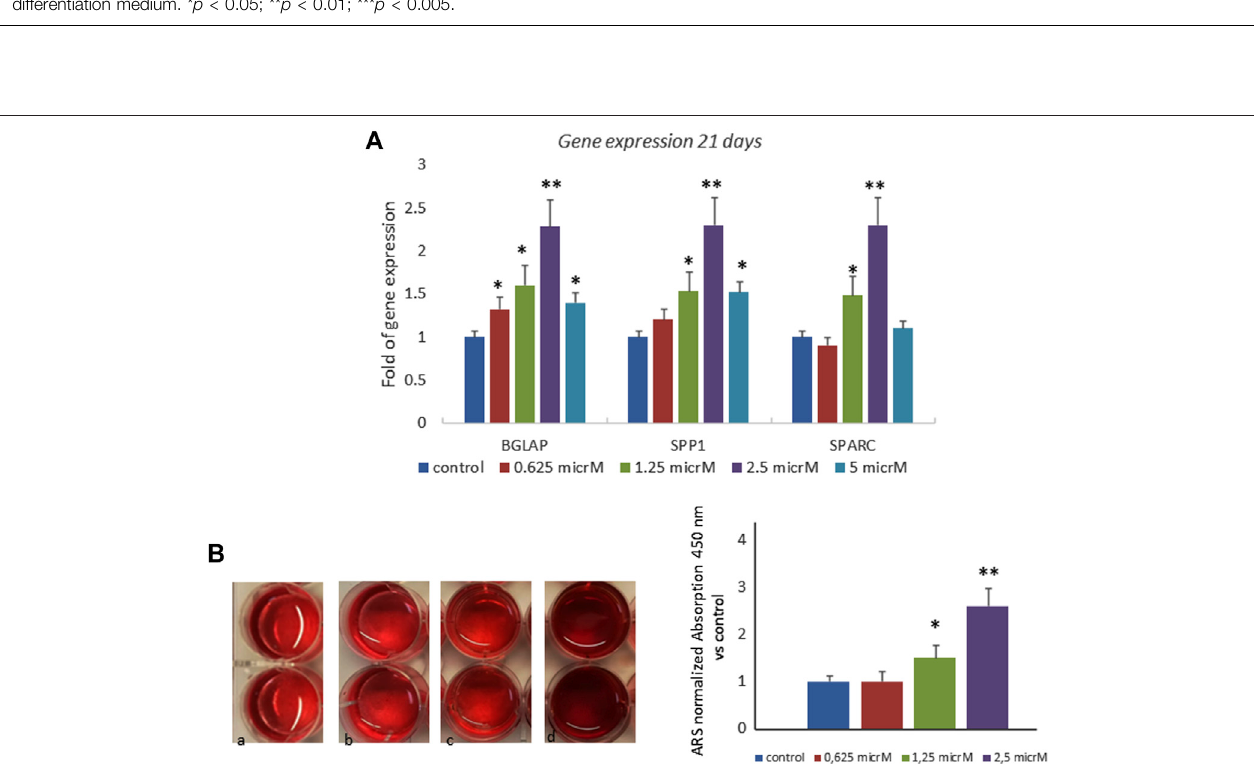
FIGURE3| Effectsof fi setinsupplementationonthelatephaseofosteogenicdifferentiation.Fisetinincreasedtheexpressionlevelsofosteogenicgenes (A) andthe mineral deposition (B) after 21 days of differentiation (mineralization phase) (a, control; b, 0.625 µM; c, 1.25 µM; d, 2.5 µM) * p < 0.05; ** p < 0.001. Magni fi cation ×4.